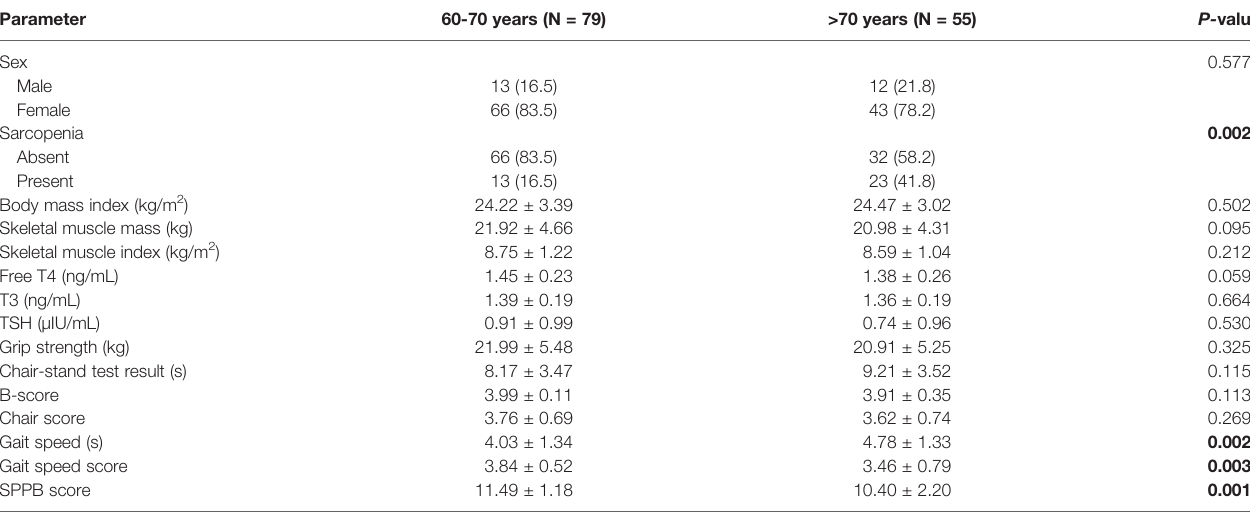
TABLE 1 | Clinical characteristics of the study sample, categorized according to age (N = 134).